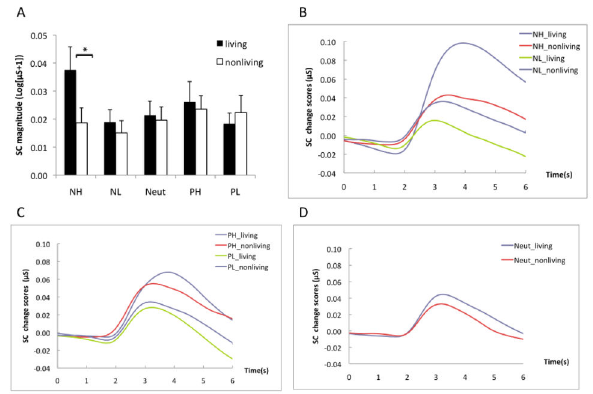
Figure 2. The results of Experiment 1. Living pictures showed stronger responses in SC magnitude than nonliving pictures in the negative-high condition (A). The average SC change waveforms are illustrated for negative (B), positive (C) and neutral (D) pictures by condition. Error bars represent standard errors of the